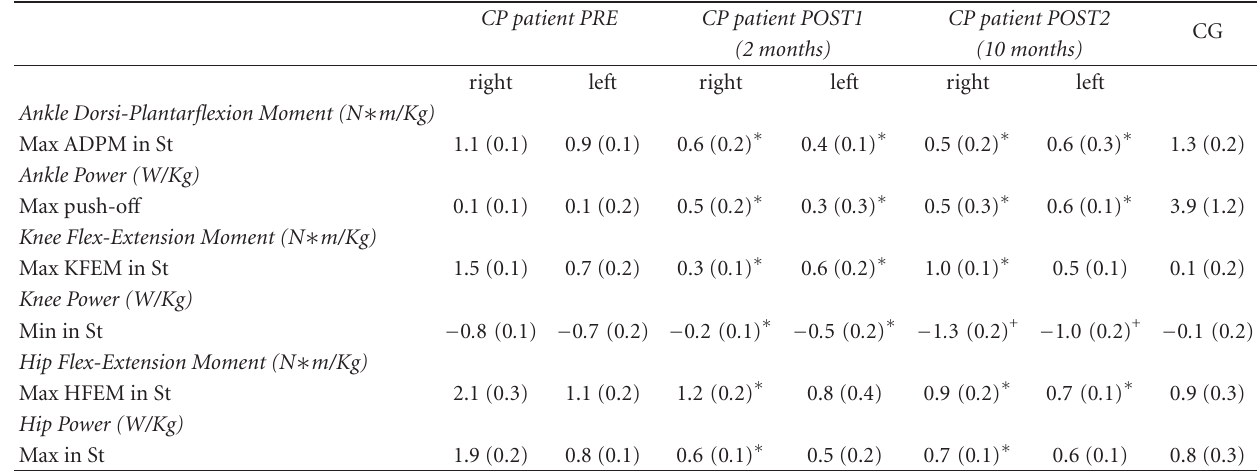
Table 3: Summary of kinetic parameters (mean and standard deviation) for analysed patient (CP patient; right and left side) in the examined sessions and normative data (Control Group, CG).